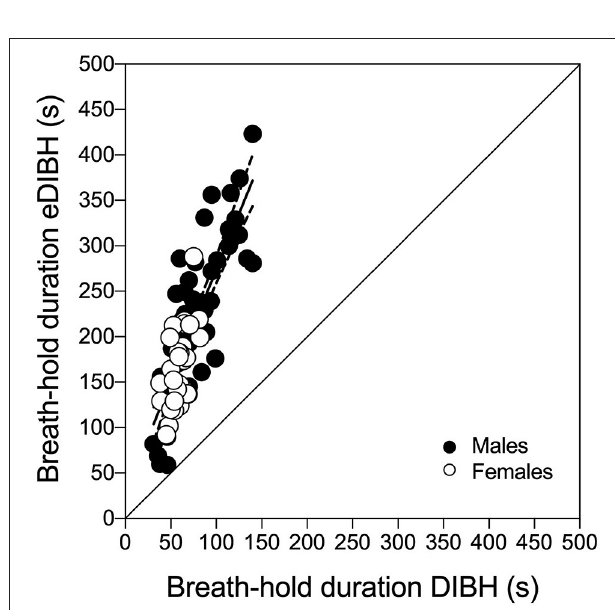
FIGURE 6 | Individual subject’s maximal deep-inspiration breath hold (DIBH) durations out of resting breathing in sitting position compared with maximal-enhanced deep-inspiration breath hold (eDIBH) duration in lying position at all visits. Best-fit line with 95% confidence bands.